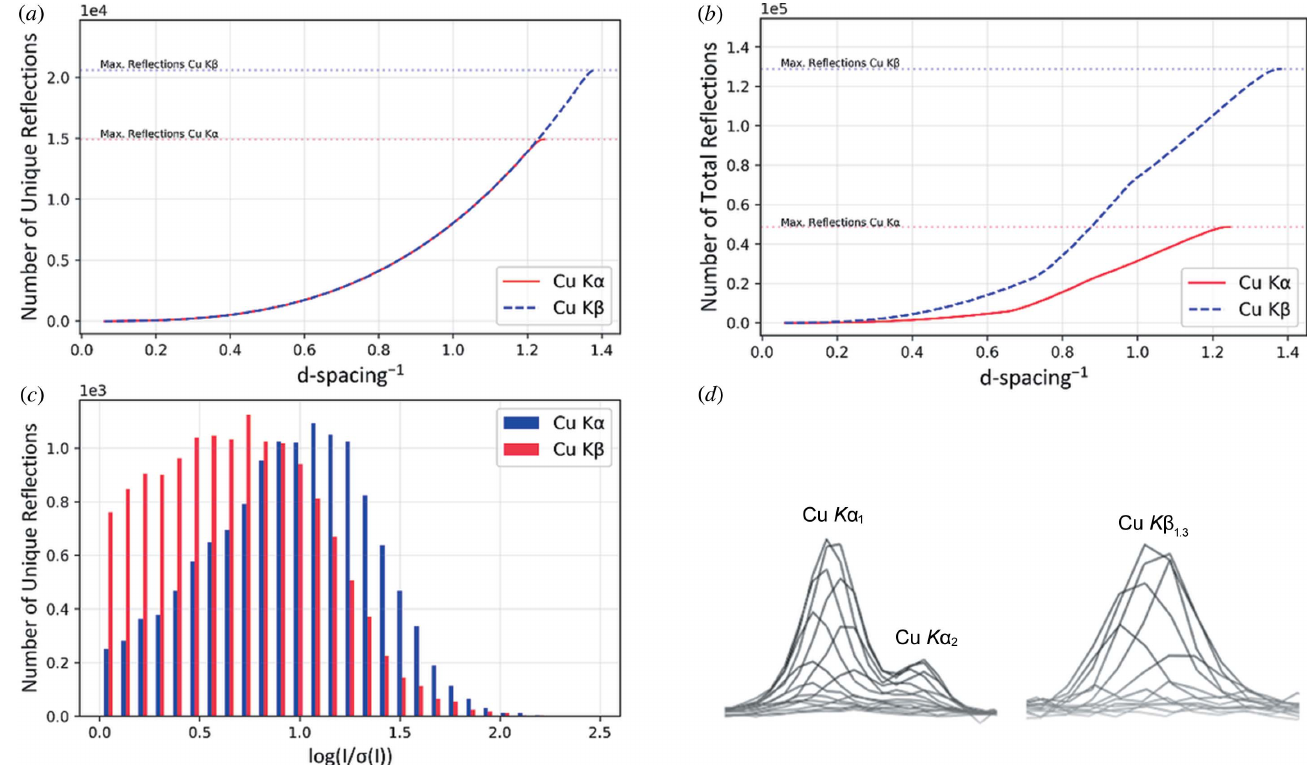
Figure 1 Increase in number of ( a ) unique and ( b ) total data with increasing resolution and ( c ) distribution of reflections versus intensity of measurements 1a and 1b. Respective plots for all measurements can be found in the supporting information. ( d ) Side profile of an arbitrarily chosen reflection (14 14 17) from experiment 1 on the detector at a resolution of 0.81 A˚ for Cu K (cid:4) and Cu K (cid:2) radiation in line